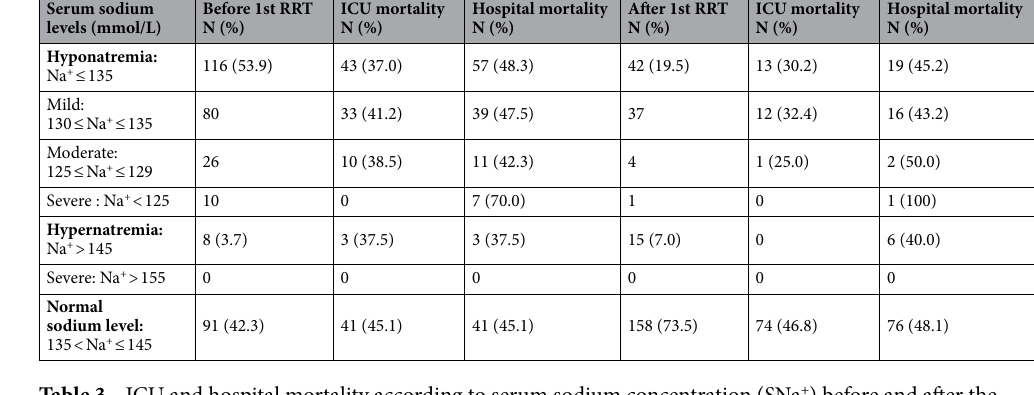
Table 3. ICU and hospital mortality according to serum sodium concentration (SNa + ) before and after the first renal replacement therapy (RRT) session. ICU intensive care unit, RRT renal replacement therapy.